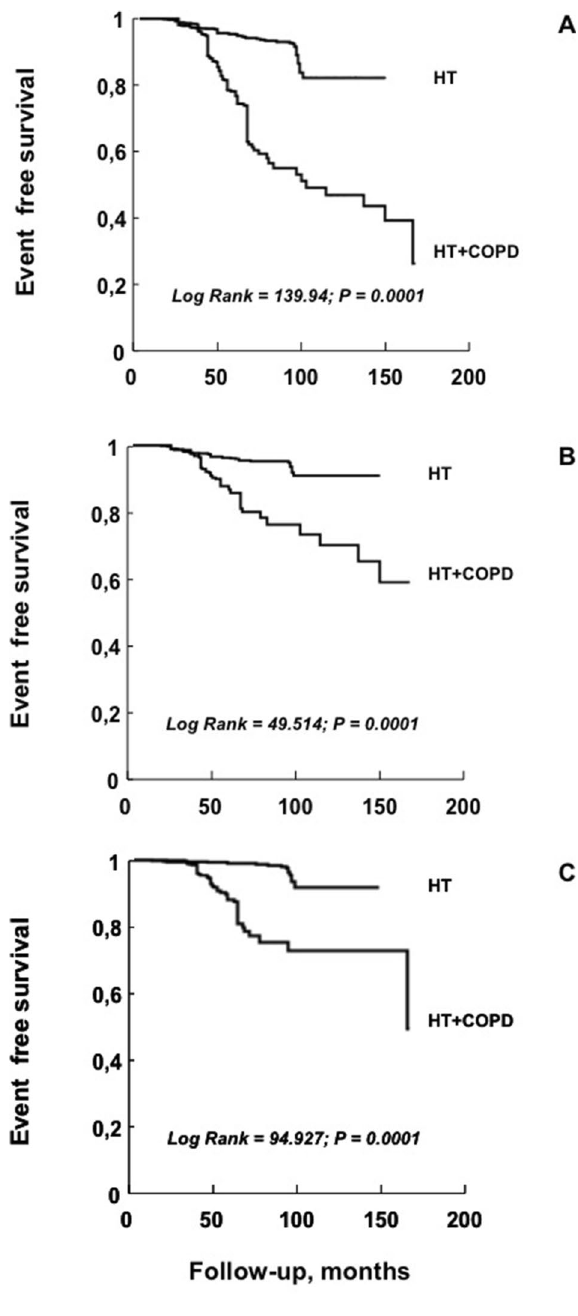
Figure 1. Kaplan–Meier curves for MACE ( A ), total myocardial infarction ( B ) and total stroke ( C ) in hypertensive patients with and without